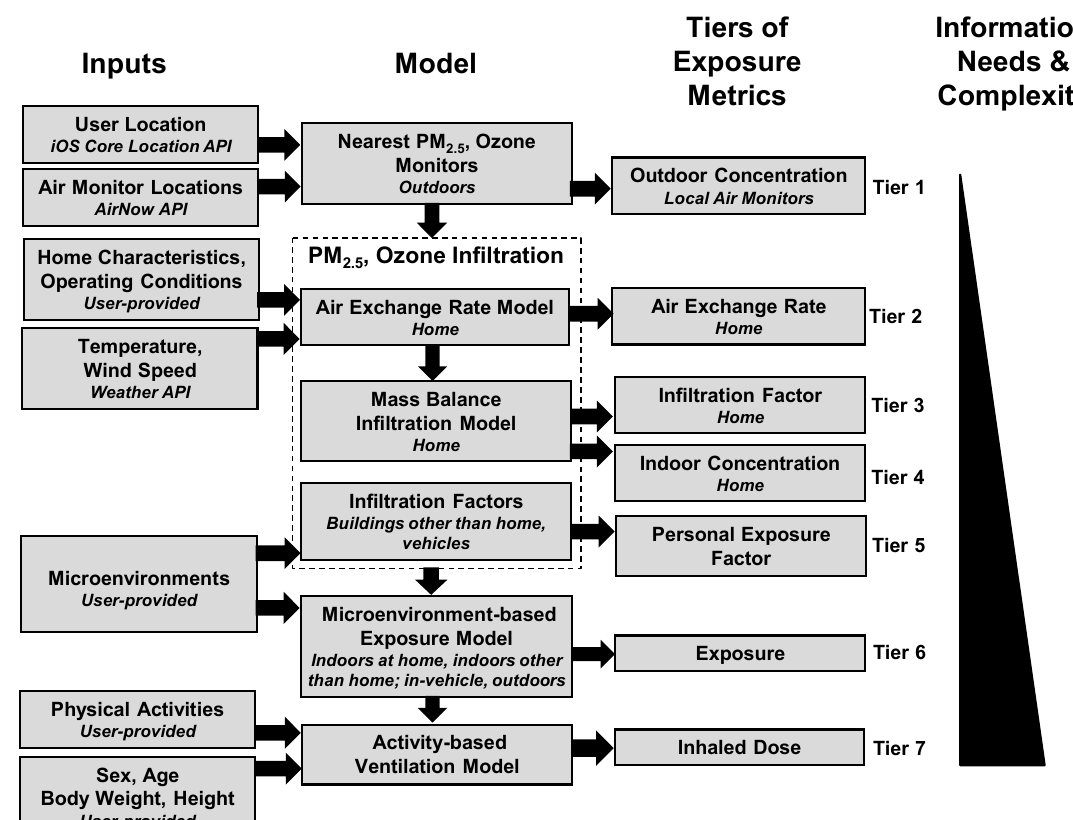
Figure 1. Conceptual model of TracMyAir to predict seven tiers of individual-level exposure metrics for ambient fine particulate matter (PM 2.5 ) and O 3 . Tier 1 consists of measured outdoor concentrations, Tiers 2 – 4 are related to homes, and Tiers 5 – 7 are related to personal exposures and dose. Model input needs and complexity increase from Tier 1 to Tier 7.